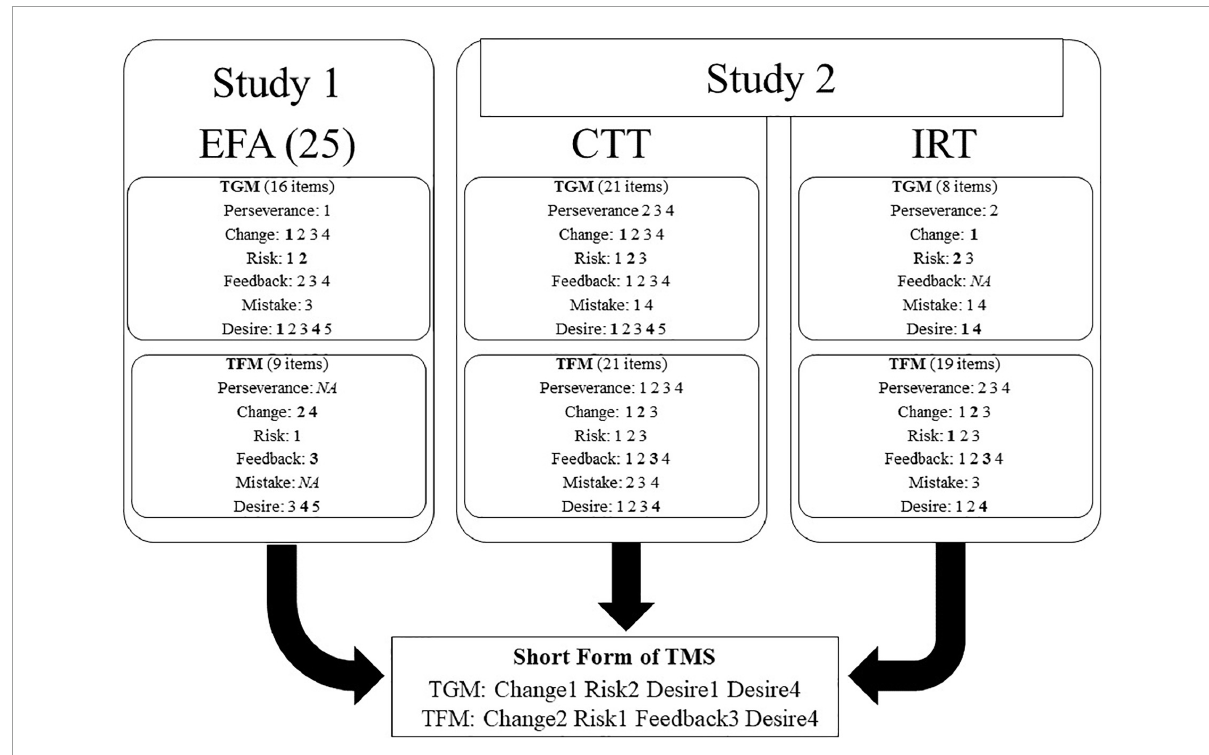
FIGURE1 The process of item selection.